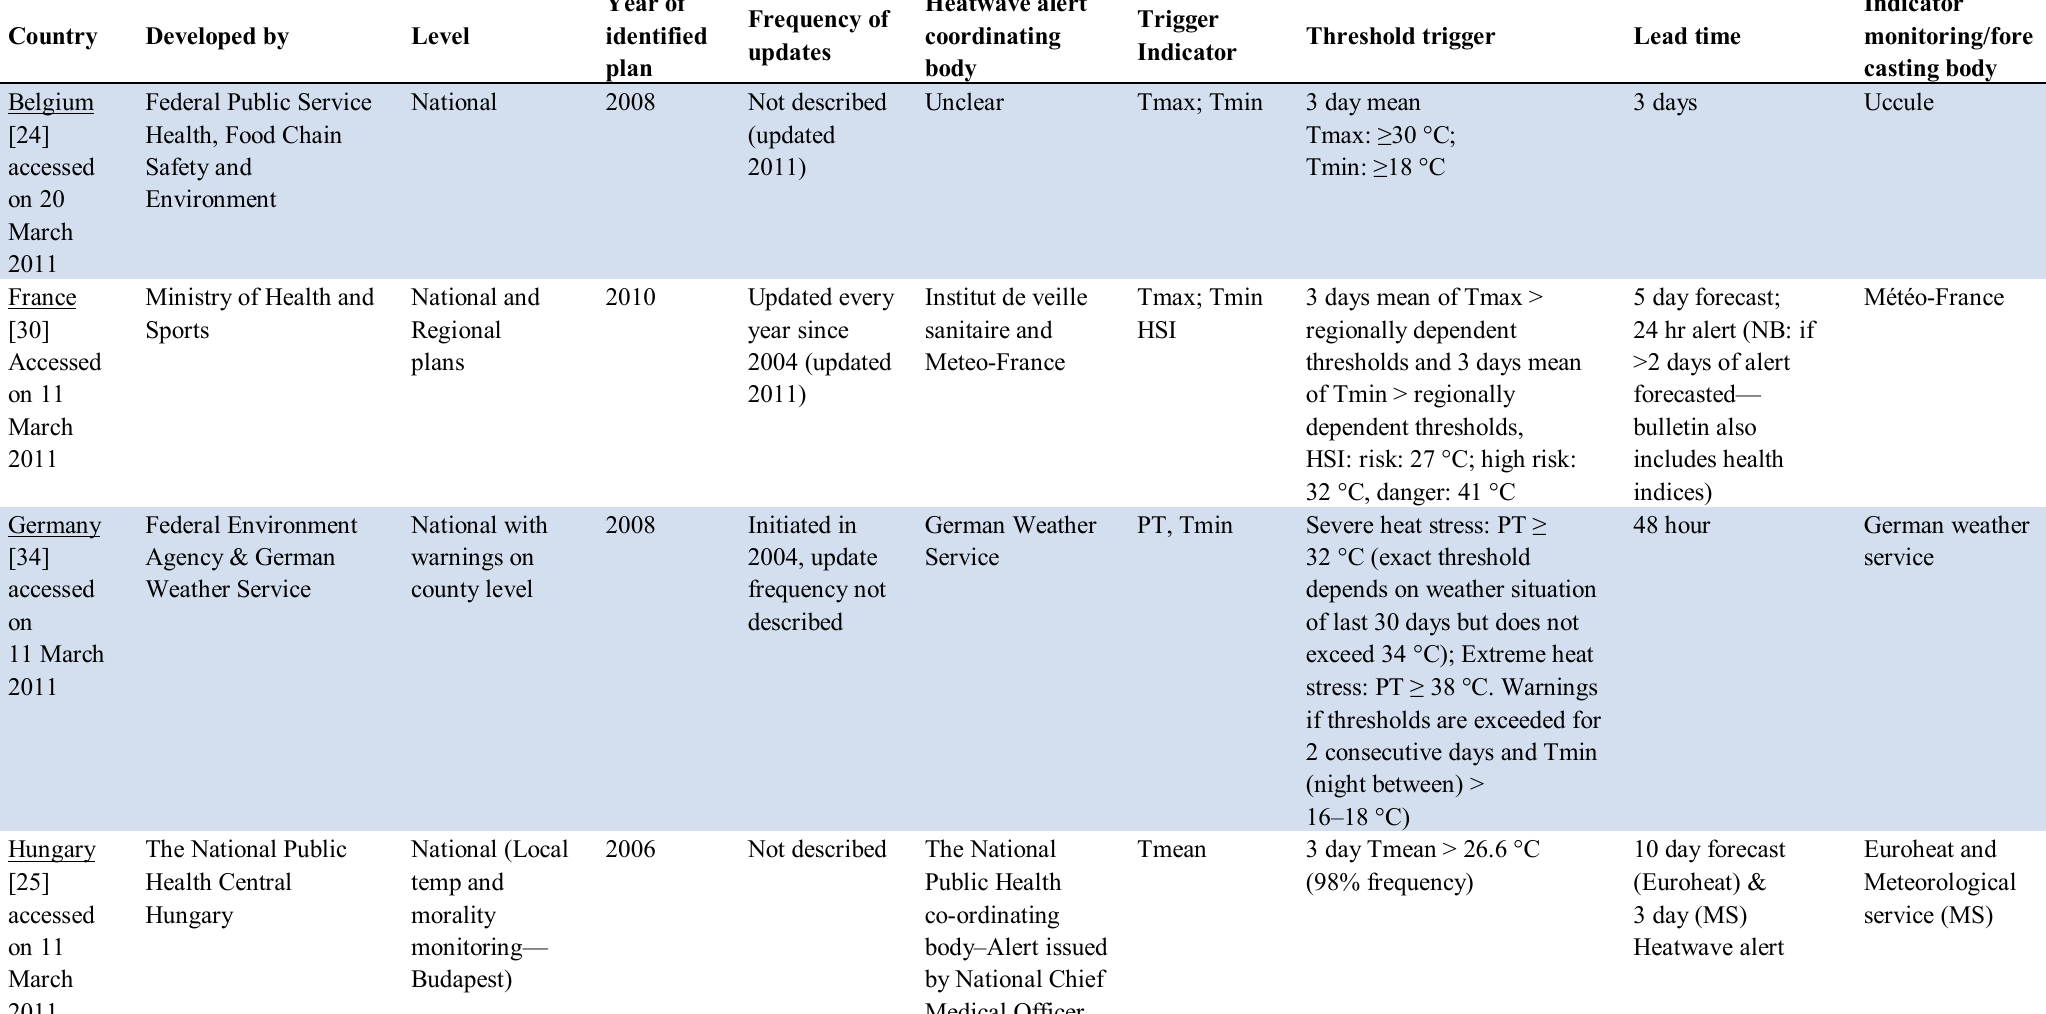
Table 1. European countries with identified heatwave early warning systems, temperature indicators and trigger